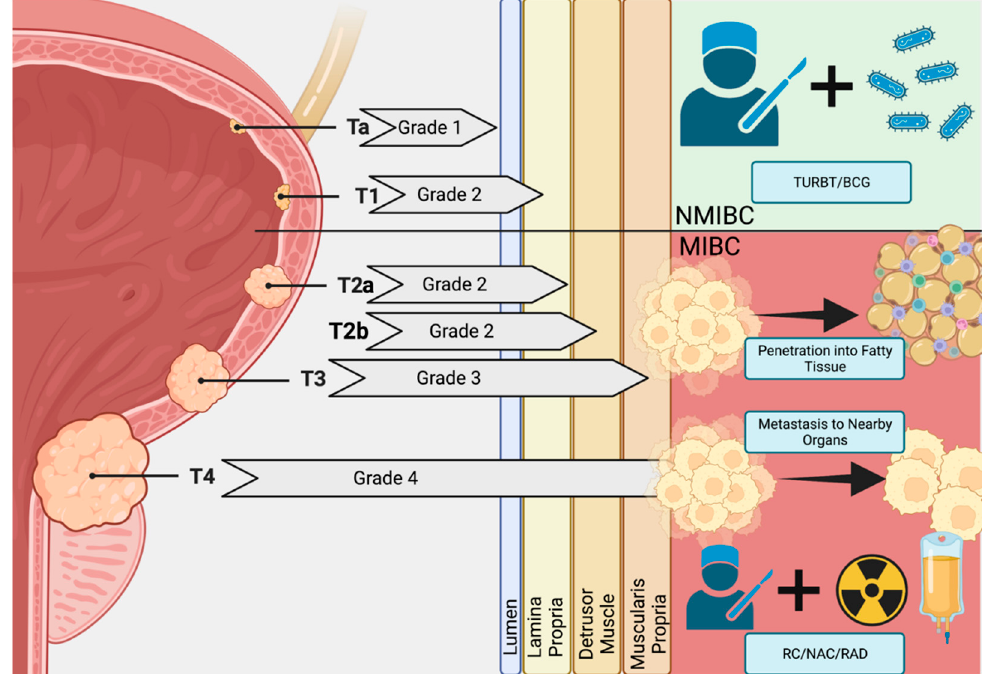
Figure 1. Bladder Cancer Pathogenesis. Early in situ carcinomas mature into Ta (Grade 1) and T1 (Grade 2) non-muscular invasive bladder cancers (NMIBC) malignancies that begin to penetrate the muscle wall of the bladder. Here, transurethral resection of the bladder (TURBT) and Bacillus Calmette–Guérin (BCG) therapy are often curative. However, a subpopulation is resistant to these therapies and the tumor penetrates the muscle wall and fatty tissue, becoming advanced-stage muscle-invasive bladder cancer (MIBC; Grades 3 and 4). With metastasis to surrounding organs, multimodal therapies featuring radical cystectomy (RC), neoadjuvant chemotherapy (NAC), and radiation (RAD) are used to increase survival by tumor growth and metastasis control. Created at Bio- Render.com.